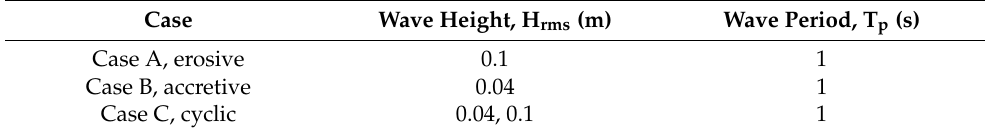
Table 1. Modelled wave